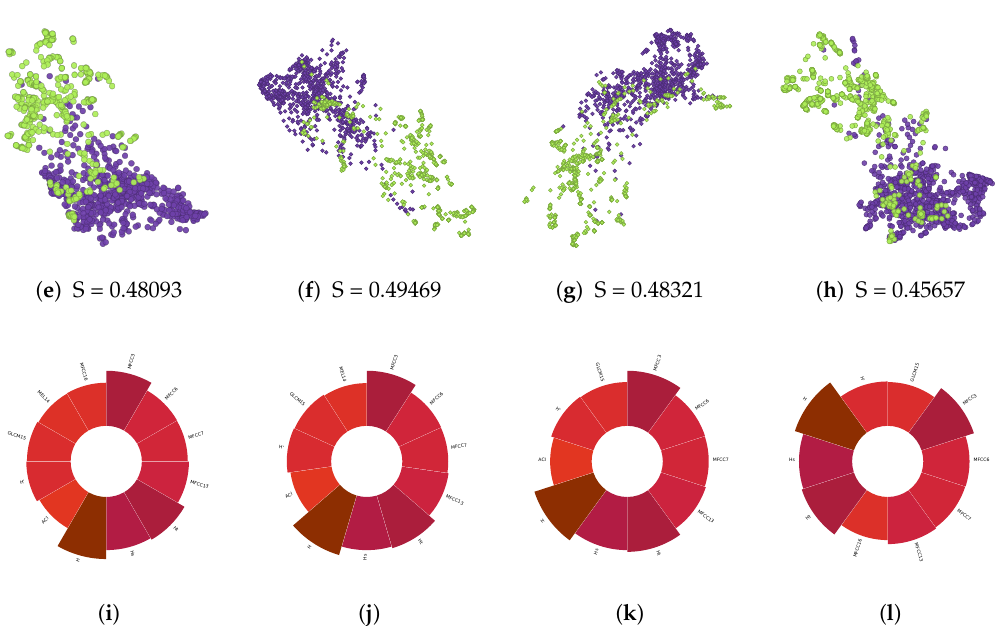
Figure 6. Soundscape ecology data of bird and insect classes with 141 features. ( a , d ) Similarity MSTs with automatically selected features and graph edges with low similarity. ( b , c ) MSTs with manually de-selected features and graph edges with low similarity. ( e – h ) LSP projection of 1662 data points from the space of selected features on 2D and silhouette coefficients. ( i – l ) Circular histogram visualization of the selected features.